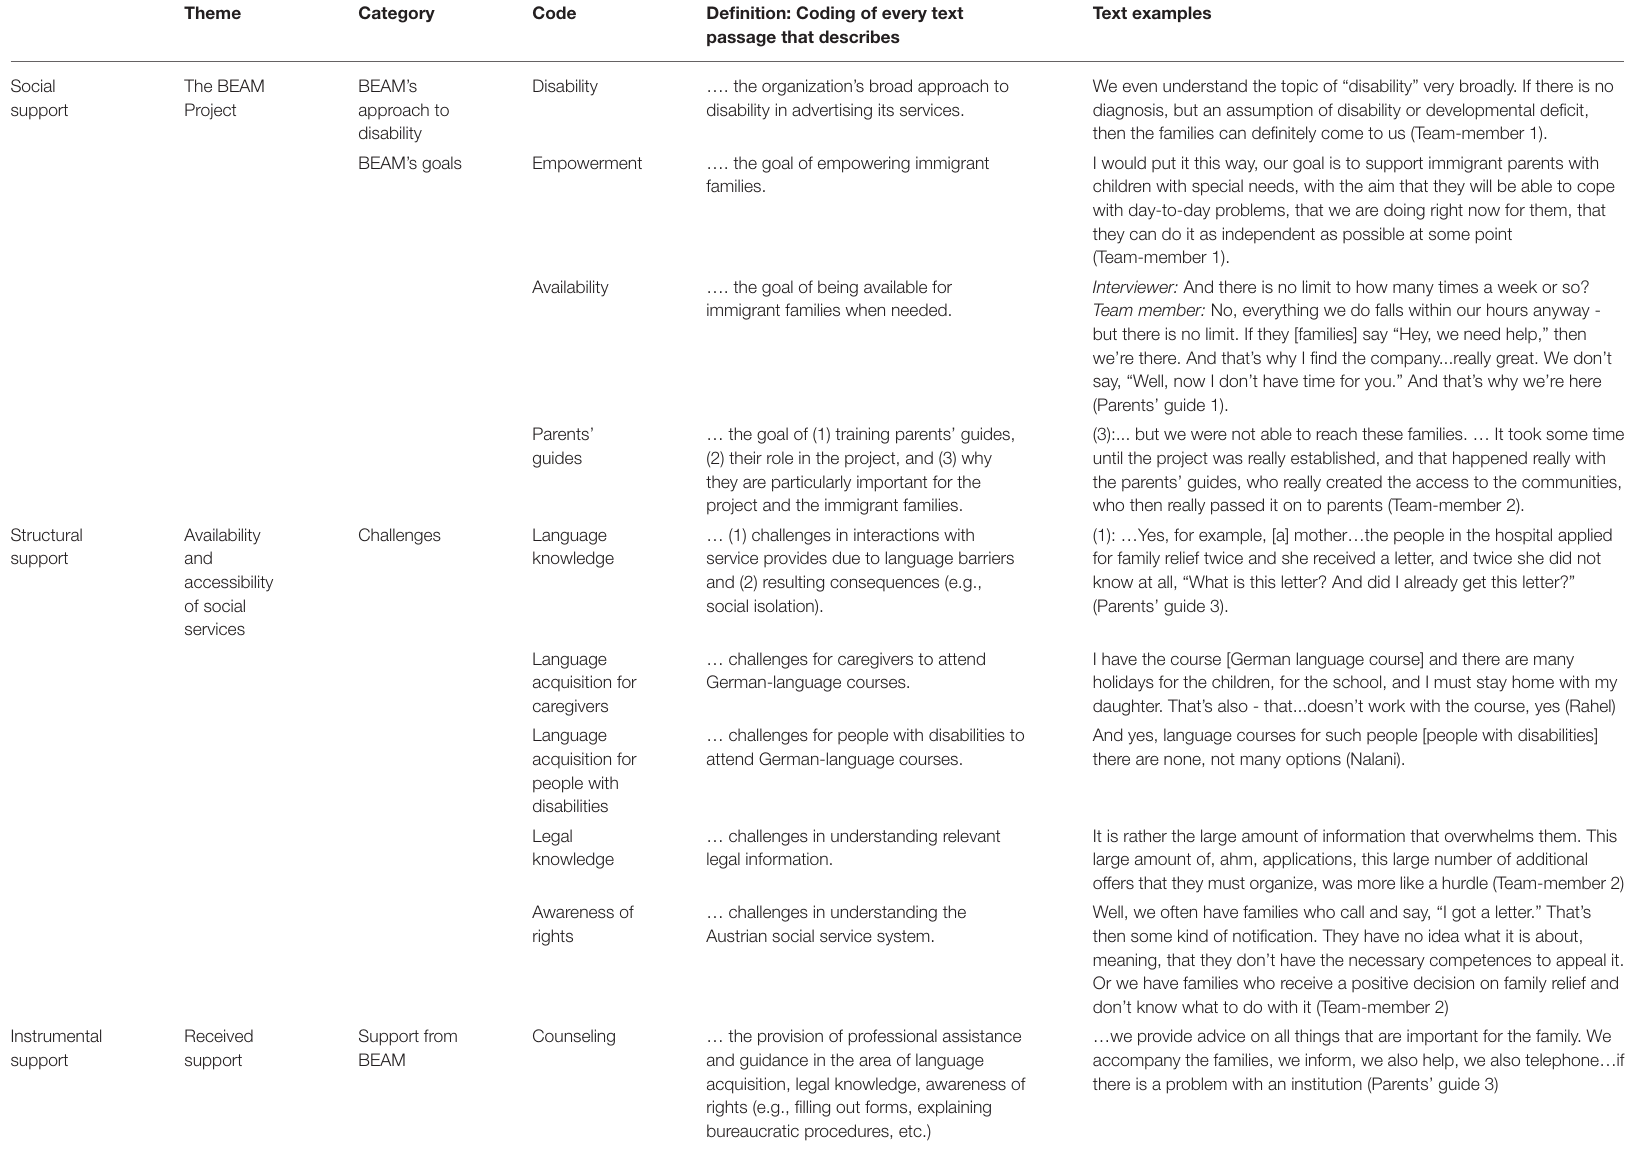
TABLE 1 | The codebook. Theme Category